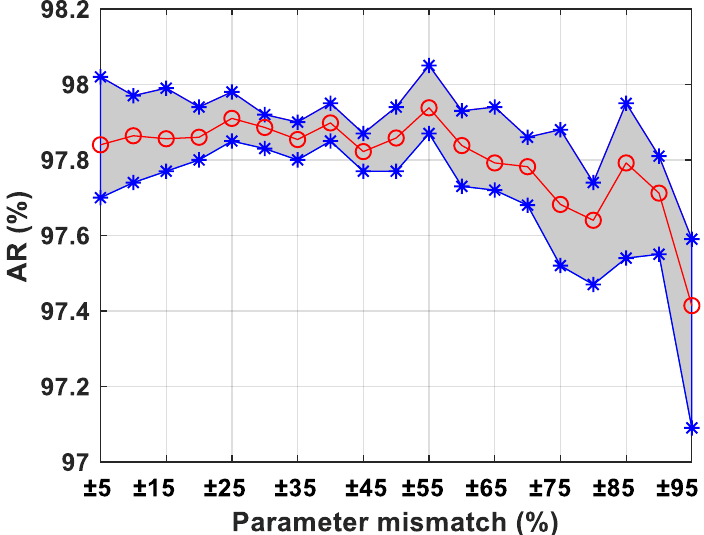
Figure 7. Impact of parameter mismatch between multiple reservoirs on the AR.